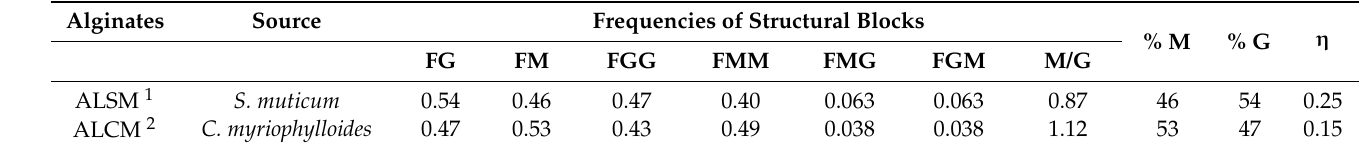
Table 4. Structural characterization of ALCM and ALSM extracted from C. myriophylloides and S. muticum